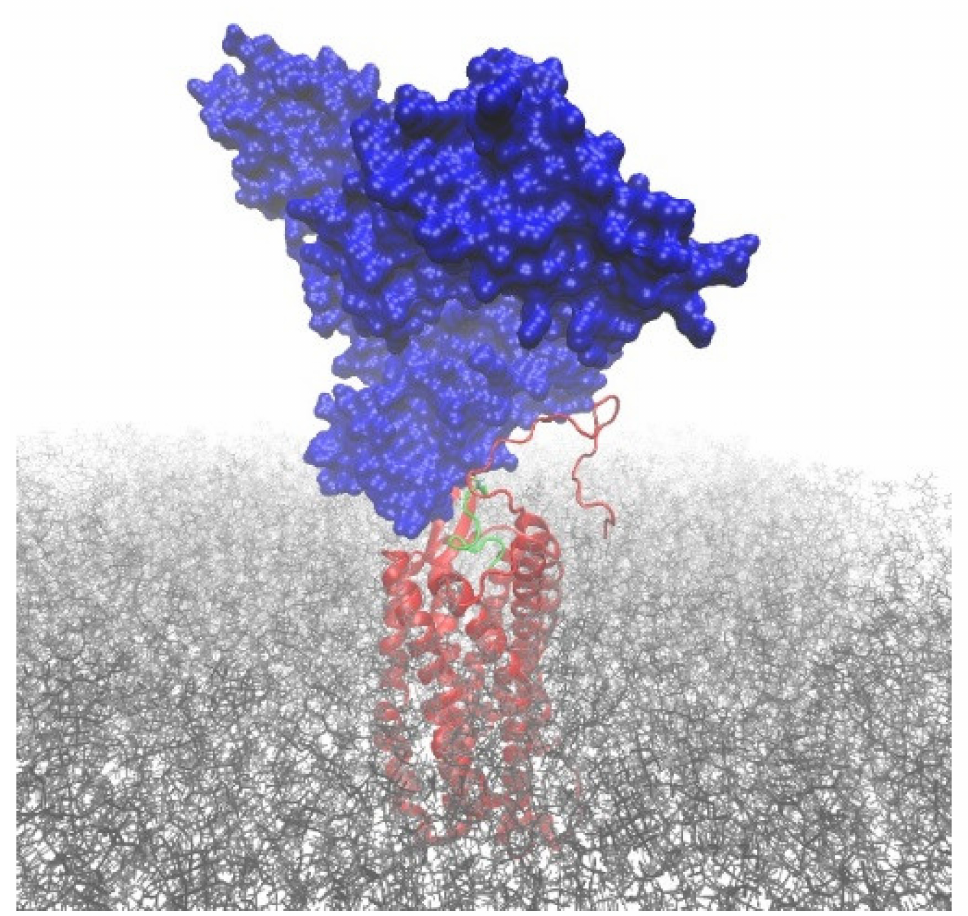
Figure 6. Computational modeling of EPI-X4 JM#21 (green) bound to albumin (blue) interacting with CXCR4 (red). The disulfide bond bridging albumin and JM#21 involves the residues Cys34(HSA) and Cys10(JM#21). The POPC membrane is shown in grey. Explicit water molecules and ions, omitted in the figure for clarity, were included in the